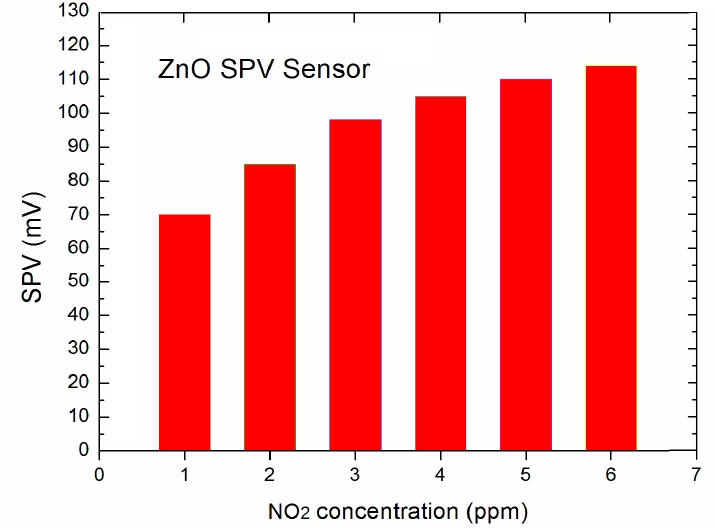
Figure 4. The variation of SPV signal as a function of NO 2 concentration.